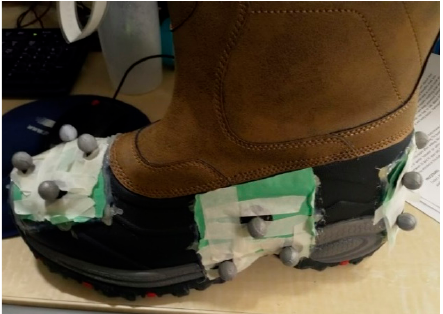
Figure 2. Reflective marker clusters were place on the anterior, posterior and lateral aspects of each pair of test